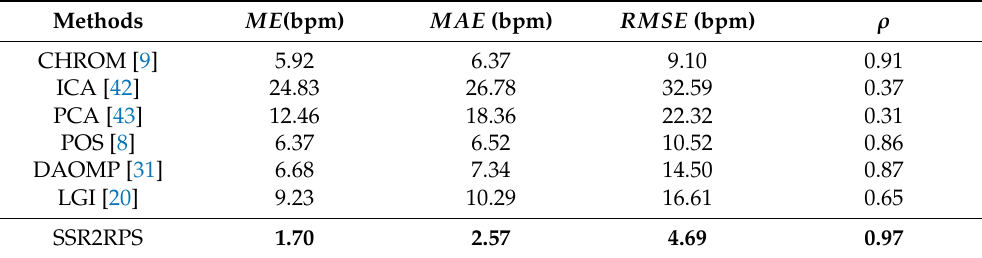
Table 1. Average heart rate prediction: comparison among different methods on UBFC dataset (best performance in bold).